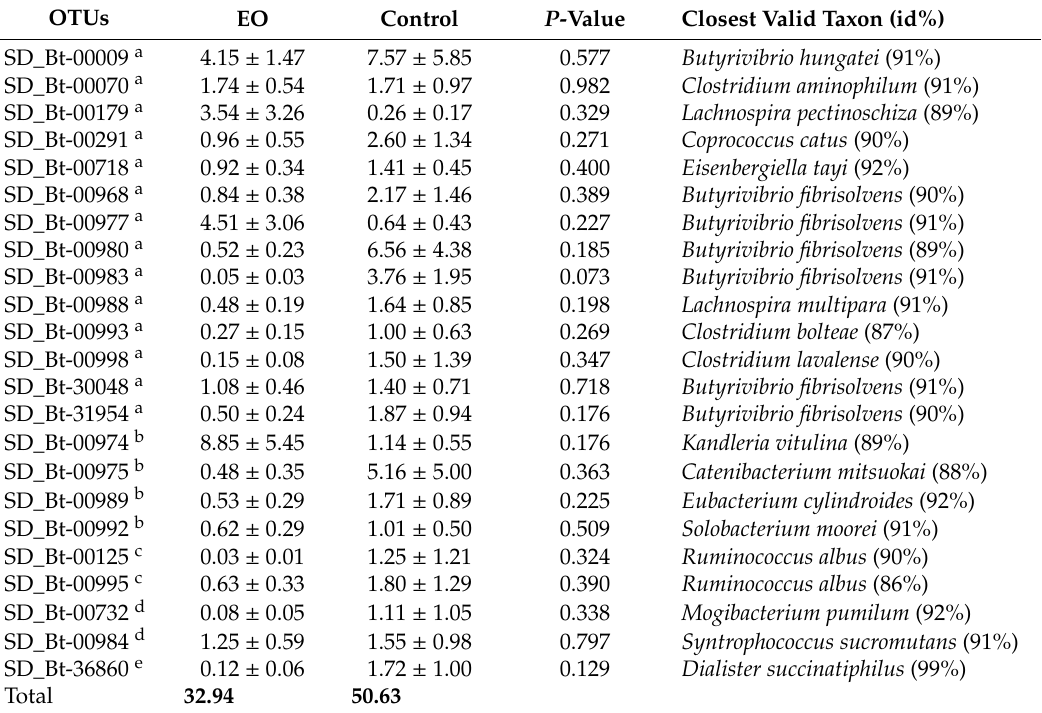
Table 4. Relative abundance (%) of main operational taxonomic units (OTUs) assigned to Firmicutes in rumen samples collected from dairy calves fed an EO-supplemented or control diet. Values shown represent mean and standard error of the mean,